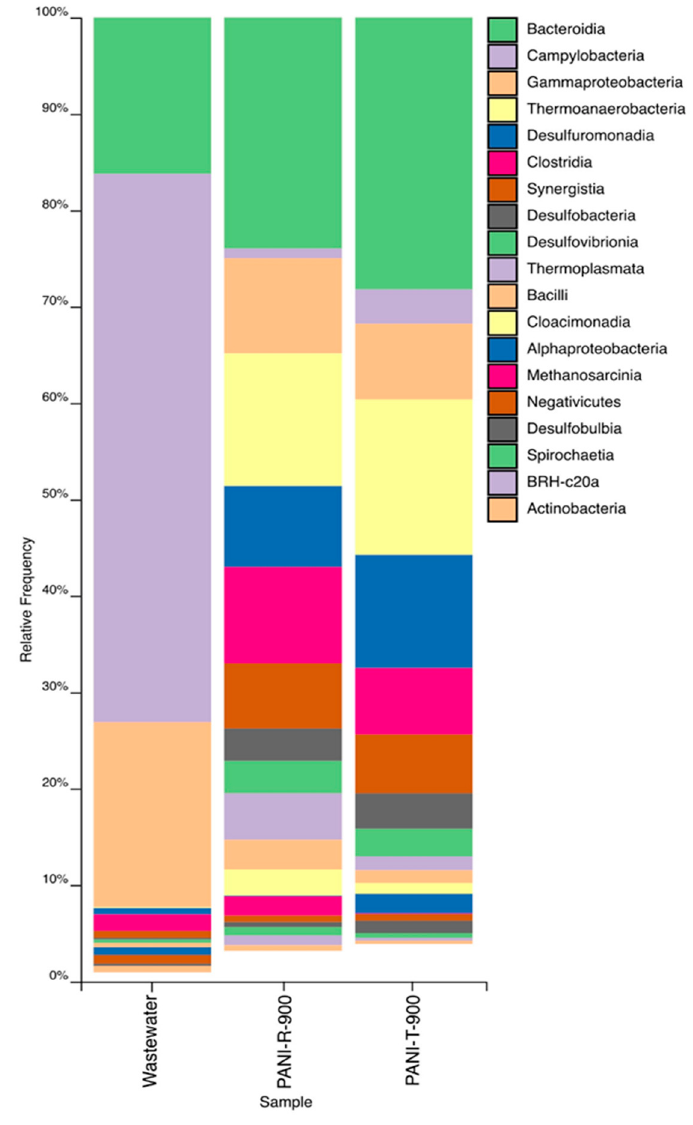
Figure 5 . Barplot representation of most abundant classes across the three sample types. Relative frequencies represent the mean-ceiling of triplicate datasets.